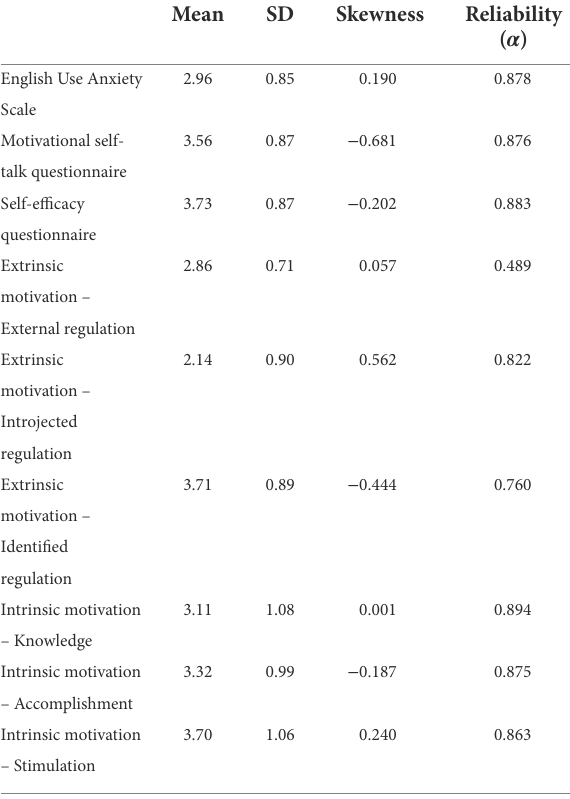
TABLE 2 Statistics of the measured variables on the scale of